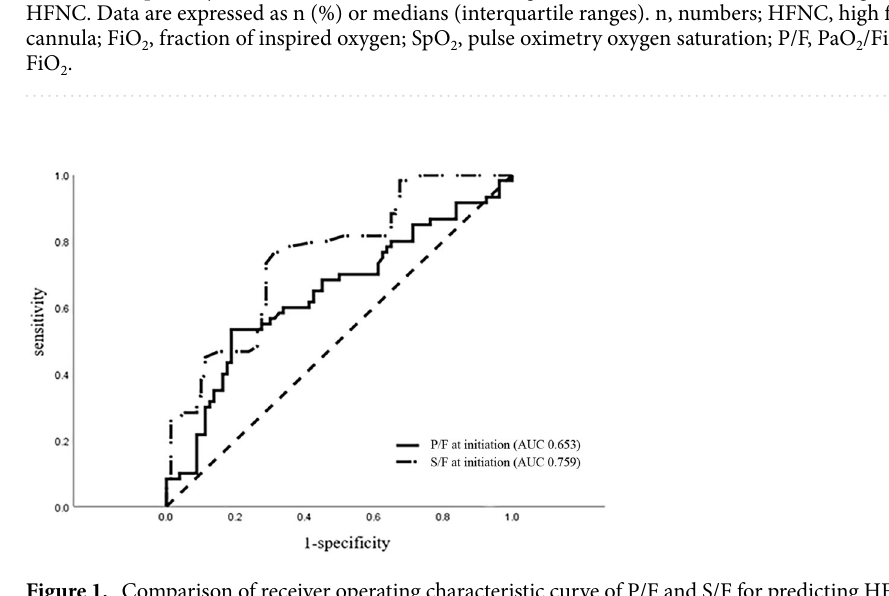
Figure 1. Comparison of receiver operating characteristic curve of P/F and S/F for predicting HFNC failure. The AUC was 0.653 for P/F at initiation and 0.759 for S/F at initiation. The difference between the AUCs was statistically significant ( P = 0.005 by Delong’s method). P/F, ratio of arterial oxygen partial pressure to fraction of inspired oxygen (PaO 2 /FiO 2 ); S/F, ratio of oxygen saturation to fraction of inspired oxygen (SpO 2 )/FiO 2 ; AUC, area under the curve; HFNC, high flow nasal